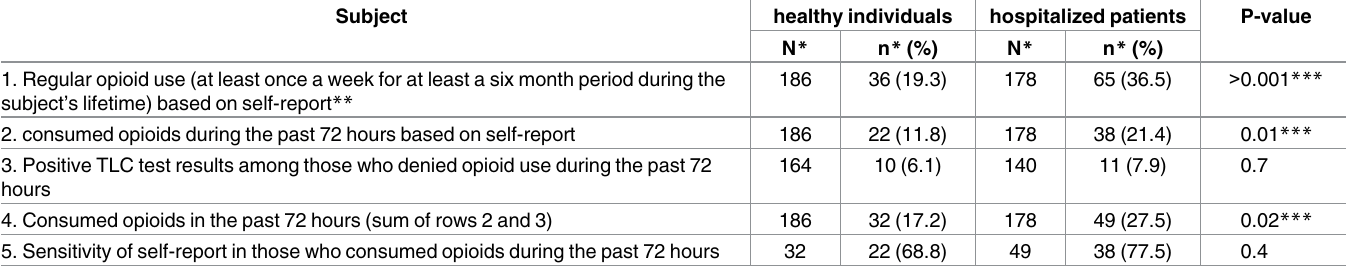
Table 2. Comparison of healthy individuals and hospitalized patients in terms of opioid use based on self-report and TLC test